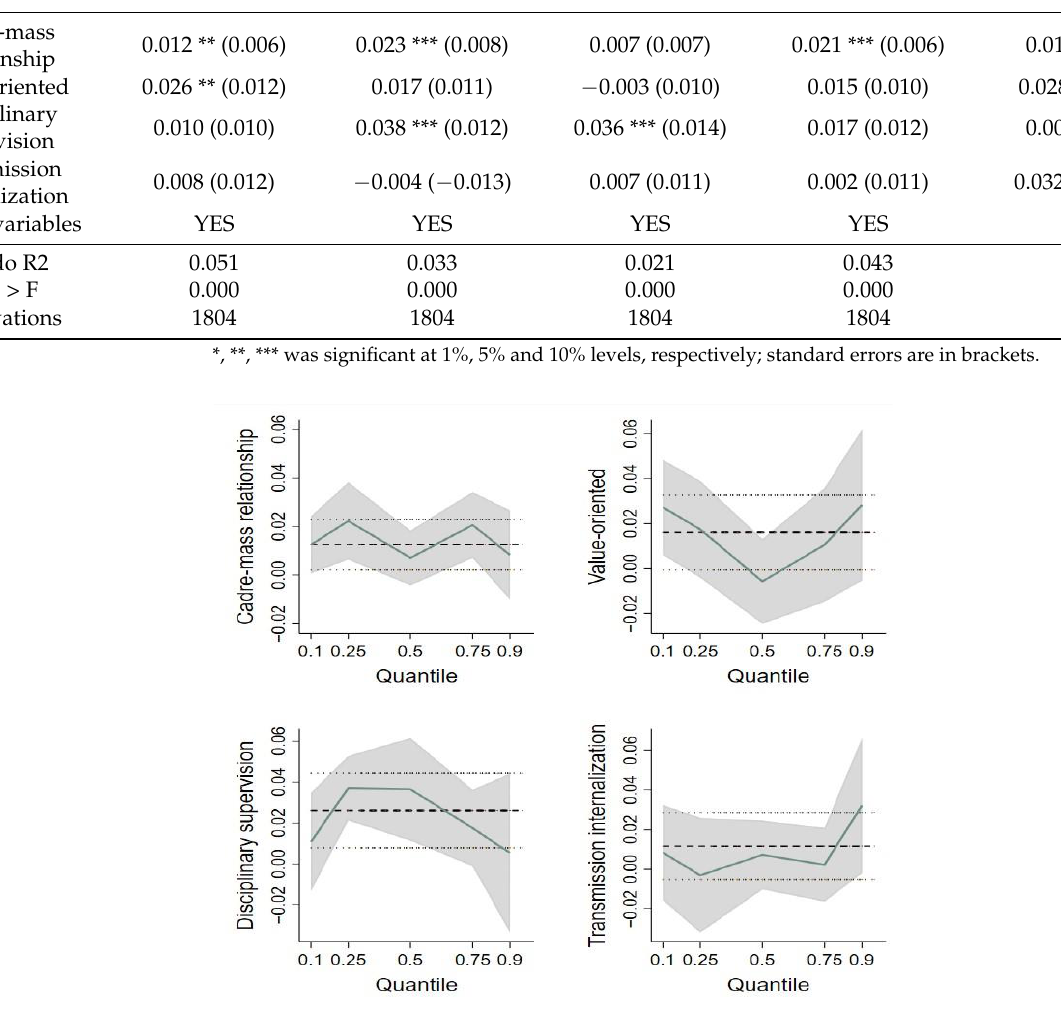
Table 5. Results of quantile regression.